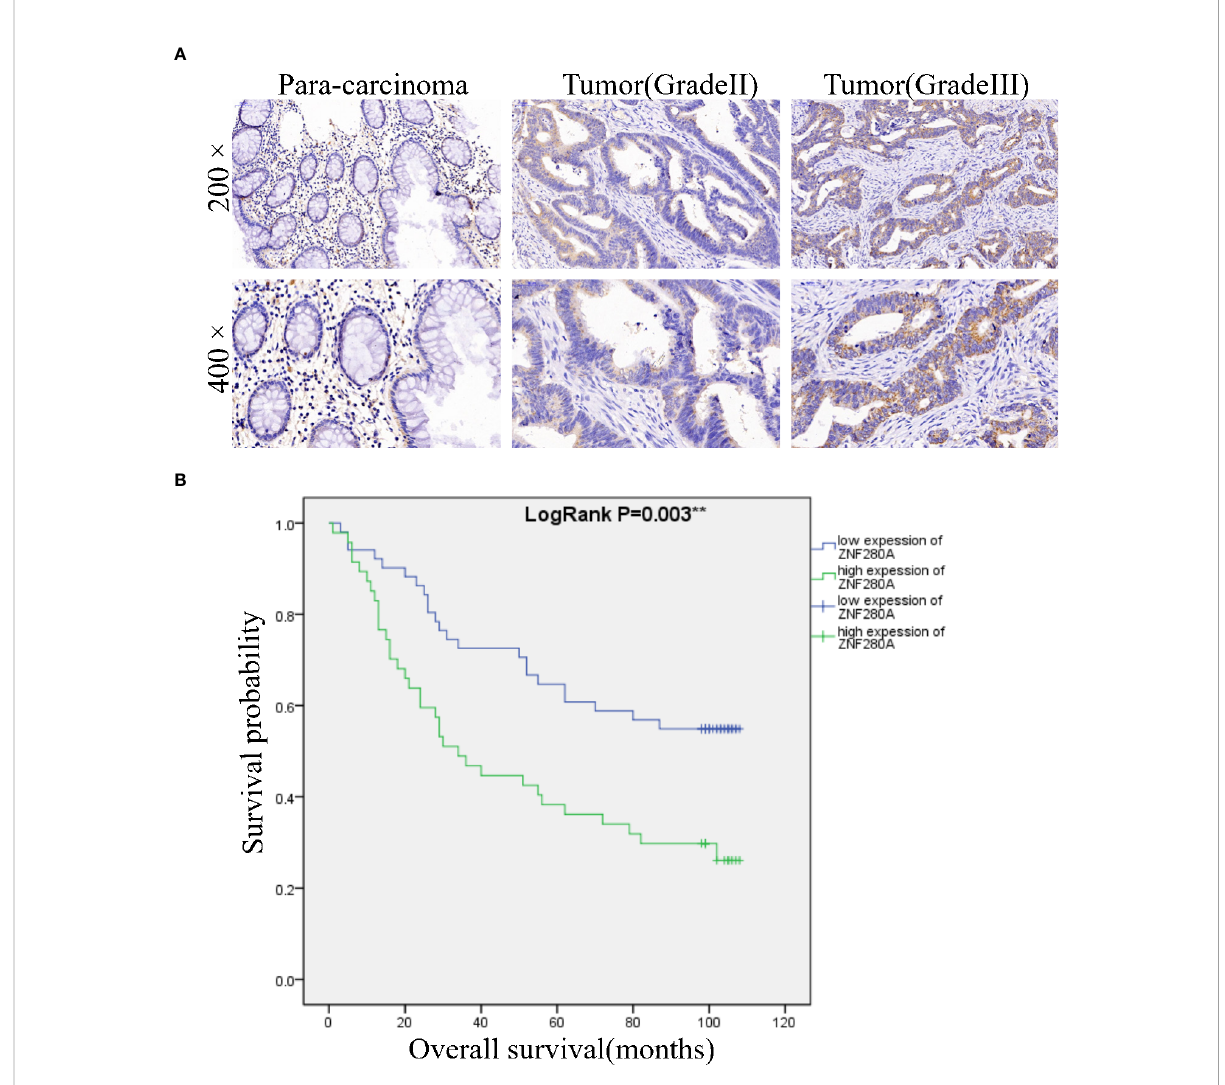
FIGURE 1 ZNF280A is highly expressed in CRC tissues. (A) The expression of ZNF280A in CRC tissues and para-carcinoma tissue was detected by IHC analysis. Scale bar: 50 m m. (B) The Kaplan – Meier survival analysis showed a signi fi cant association between ZNF280A high expression and shorter survival period of CRC patients. **P <